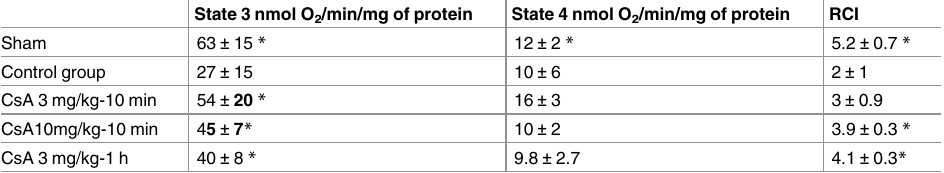
Table 1. Oxidative phosphorylation 24 h after reperfusion in CsA-treated,sham and control mice. State 3 nmol O 2 /min/mg of protein State 4 nmol O 2 /min/mg of protein RCI Sham 63 ± 15 * 12 ± 2 * 5.2 ± 0.7 * Control group 27 ± 15 10 ± 6 2 ± 1 CsA 3 mg/kg-10 min 54 ± 20 * 16 ± 3 3 ± 0.9 CsA10mg/kg-10 min 4 5 ± 7 * 10 ± 2 3.9 ± 0.3 * CsA 3 mg/kg-1 h 40 ± 8 * 9.8 ± 2.7 4.1 ± 0.3 * State 3 and state 4 were measured in isolated mitochondria with pyruvate/malate/glutamate as substrates